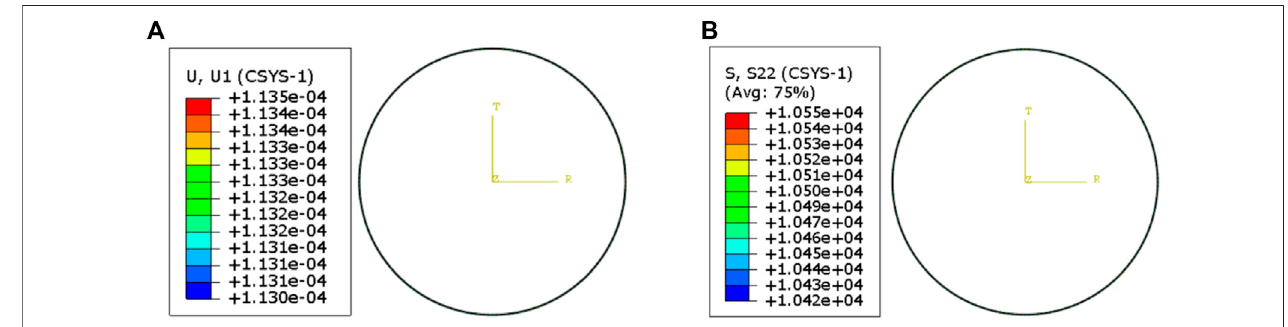
FIGURE7| Radialdeformationandcircumferentialstressofsteelpipelining. (A) Radialdeformationofsteelpipelining. (B) Circumferentialstressofsteelpipelining.